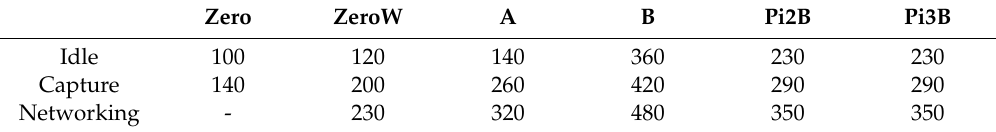
Table 1. Power consumption comparison in mAh of di ff erent versions of Raspberry